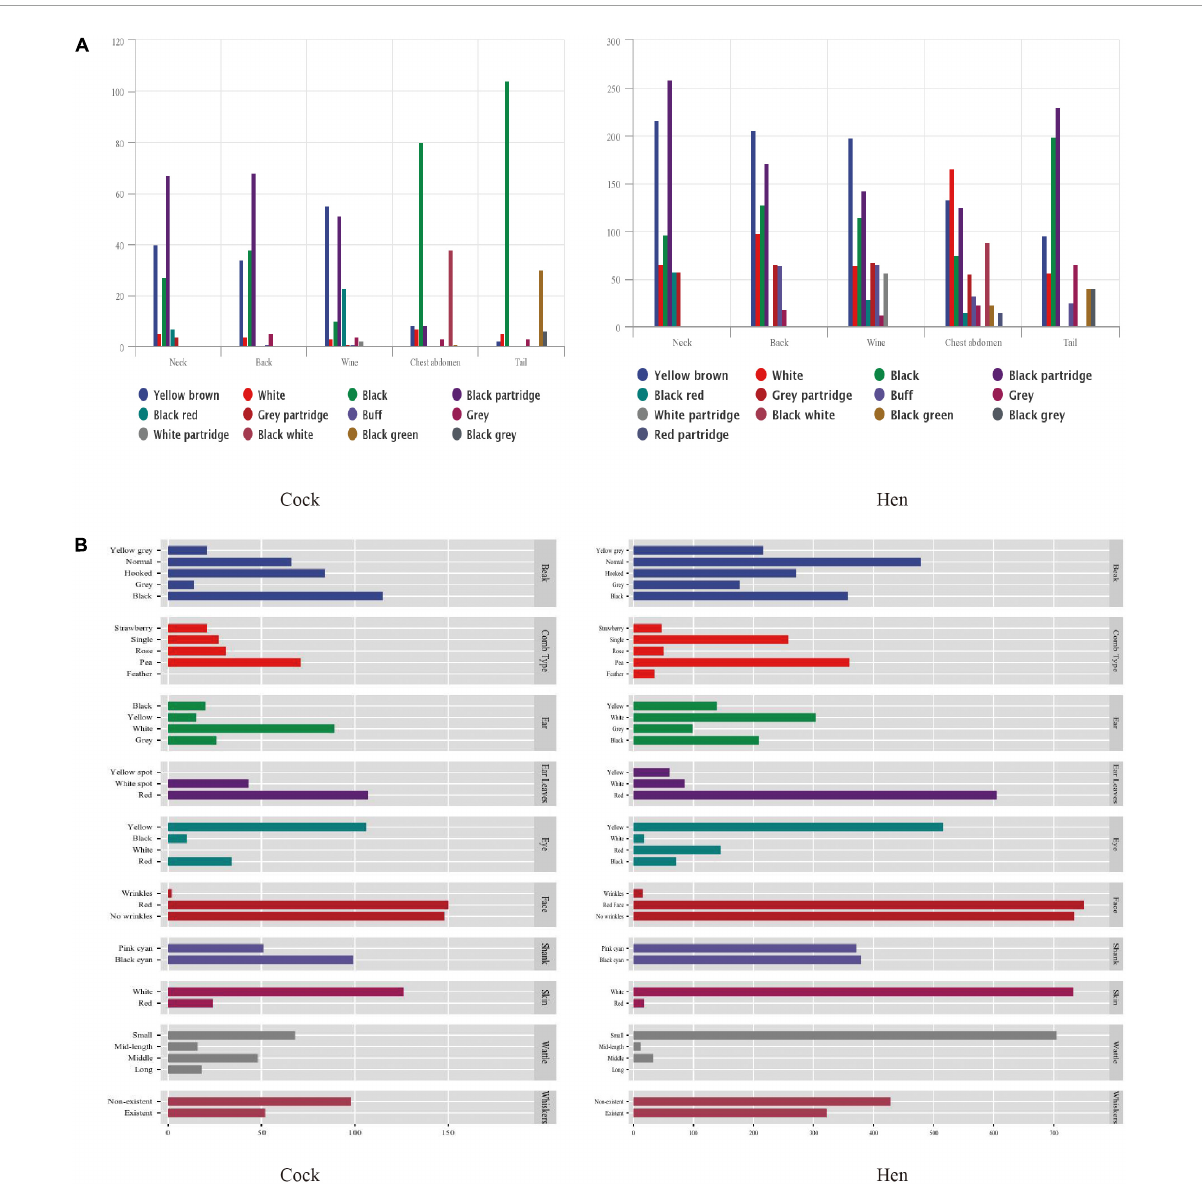
FIGURE2 Plumage colors and morphological characteristics of the Anjian chickens. (A) Plumage colors; (B) morphological characteristics.